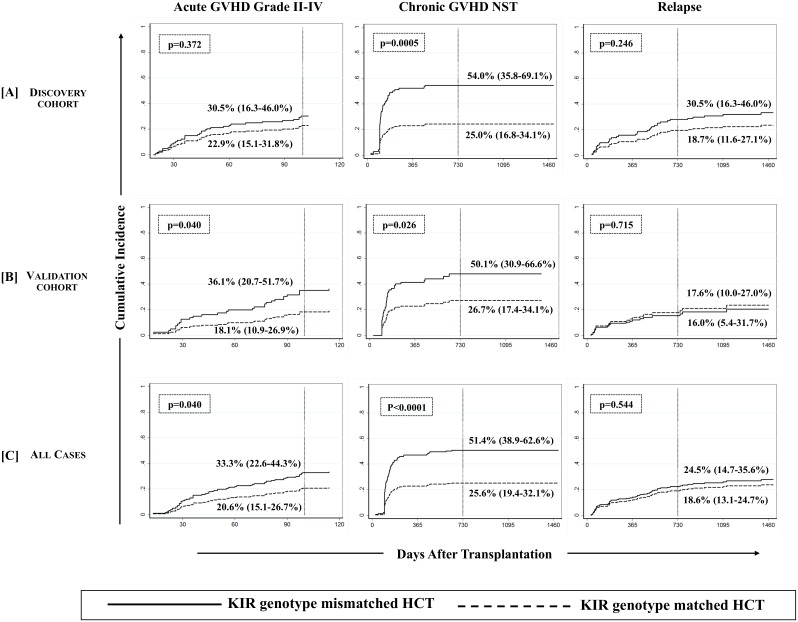
Cumulative incidence function estimates from competing risks data for GVHD and relapse.Cumulative incidences (vertical reference lines) of aGVHD grade II-IV (at day 100 post-transplant, left panel), cGVHD needing systemic therapy (middle panel) and relapse (at 2 years post-transplant, right panel) are presented across [A] discovery, [B] validation and [C] combined cohorts. Gray’s method of cumulative incidence function estimation for competing risks data revealed significantly higher incidences of cGVHD when KIR genotype mismatched donors were used (p-values <0.05 at the end of follow-up).